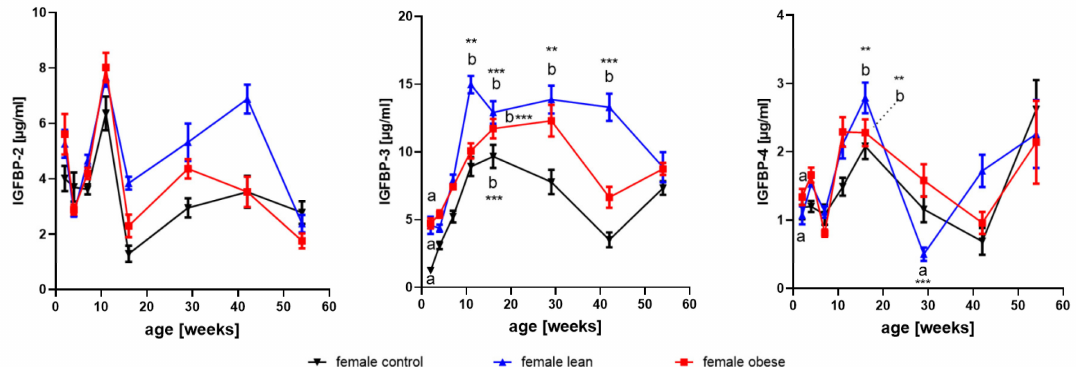
Figure 3. Concentrations of insulin-like growth factor binding protein (IGFBP) -2, -3, and -4 in serum from female mice selected for high body weight (obese), for high protein amount (lean), and in unselected controls at an age of 2, 4, 7, 11, 16, 29, 42, and 54 weeks (mean ± SEM; n ≥ 7; di ff erent letters (a and b) indicate significant e ff ects also if di ff erent genetic groups were compared; identical letters indicate no statistically significant di ff erence; **: p < 0.01; ***: p < 0.001).